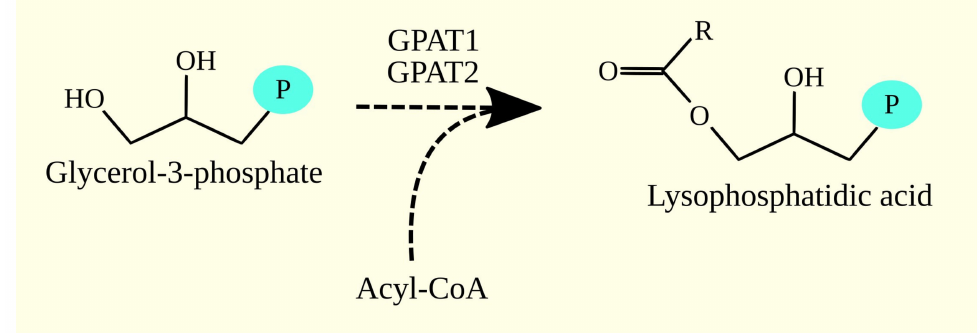
Figure 2. GPAT enzymes participate in the biosynthesis of lysophosphatidic acid from glycerol-3- phosphate. They require fatty acyl-CoA to catalyze this reaction.